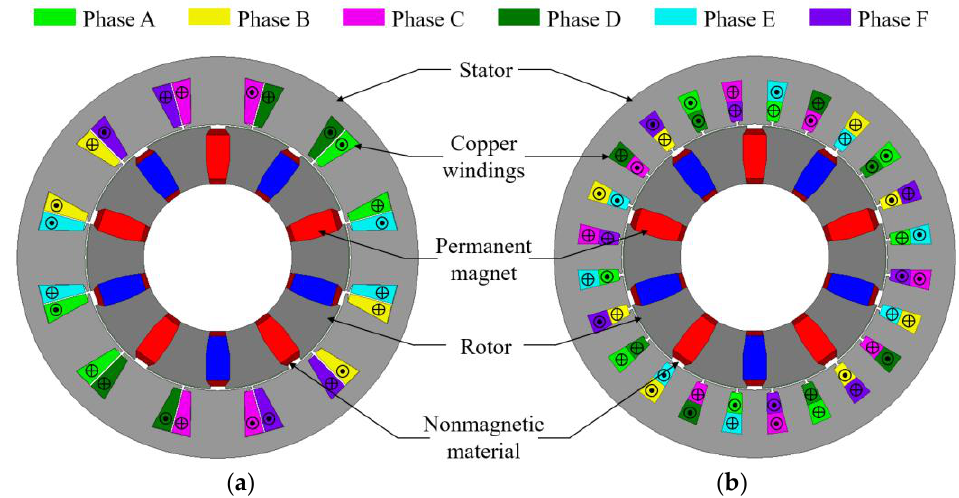
Figure 3. Schematic of 6-phase ( a ) 12-slot/10-pole unshifted and ( b ) 24-slot/10-pole stator-shifted FSCW winding layout.